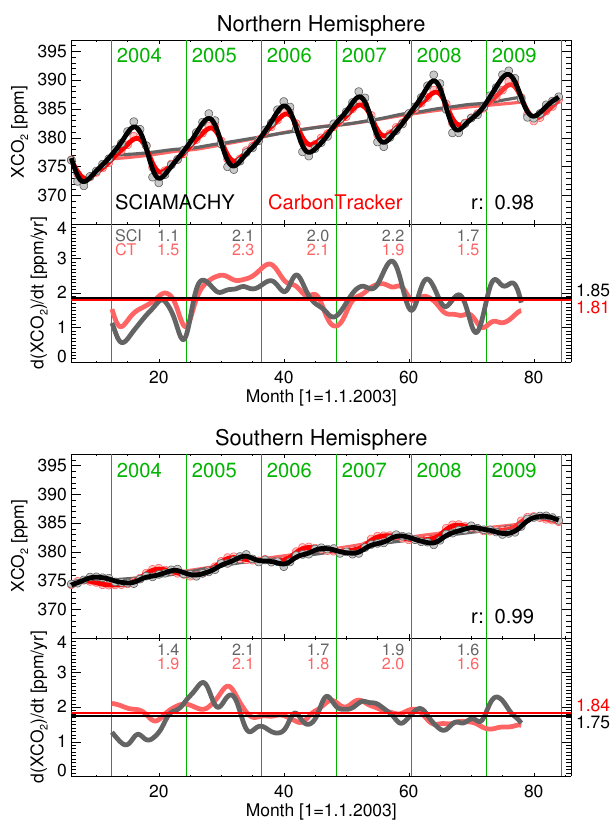
Fig. 1. The analysed SCIAMACHY XCO 2 data set (black) com- pared to the assimilation system CarbonTracker (red) for the North- ern Hemisphere (top) and the Southern Hemisphere (bottom) based on monthly means (circles). The saturated solid lines have been smoothed using a four-month Hann window (which has a simi- lar frequency response to a two-month boxcar filter but better at- tenuation of high frequencies). The pale solid lines represent the corresponding deseasonalised trends derived using a 12-month run- ning mean. Shown below are the derivatives of these deseasonalised curves corresponding to the current increase at the considered point in time. Also noted are yearly mean values of the derivatives (in pale colours) as well as the mean value of the whole time period on the right hand side. The retrieved steady increase of atmospheric carbon dioxide of just less than 2ppmyr − 1 is attributed to anthropogenic emissions and quantitatively in line with